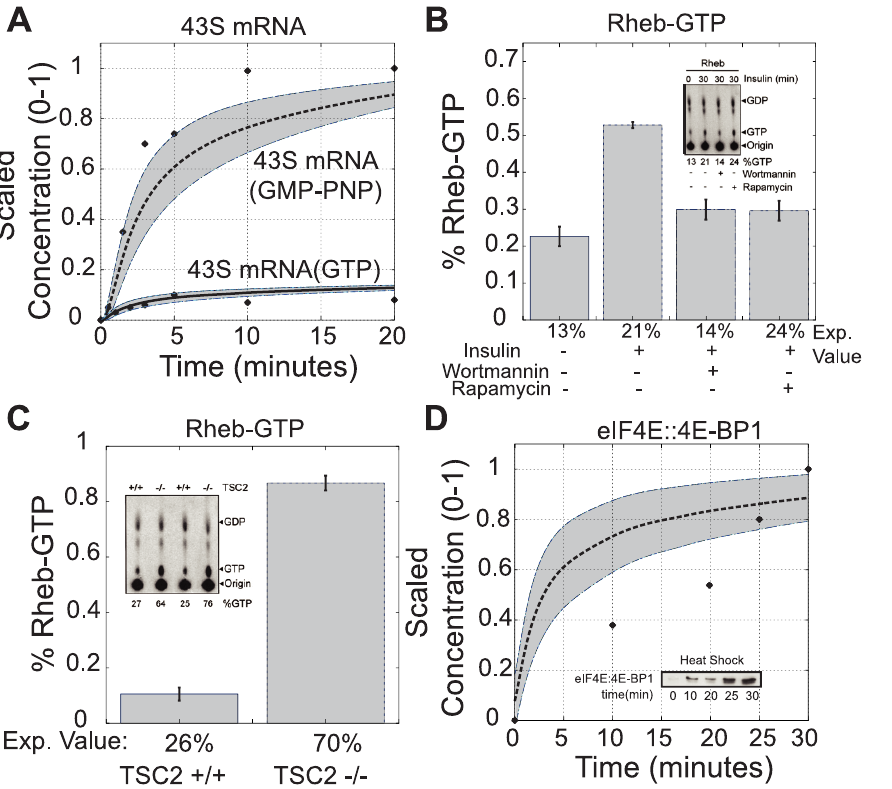
Figure 4. Blind model predictions for the ensemble (N=400). The predictive ability of model ensemble was assessed by comparing model performance with novel experimental data. Dotted lines represent the simulation mean of the ensemble, while the shaded region denotes the 99.9% confidence estimate for the mean. The solid dots represent the scaled experimental data. A. In vitro time course for formation of 43S-mRNA complex. A slowly-hydrolyzable GTP homologue (GMP-PNP) was used in place of GTP to isolate formation of this intermediate complex. GMP-PNP data was used for training while GTP data was used for validation. B. Percent of Rheb-GTP to Rheb-GDP in the presence of insulin, wortmannin and rapamycin (A14 NIH 3T3 cells). C. Percent of Rheb-GTP to Rheb-GDP in wildtype and TSC2 lacking cells (MEF cells). D. 4EBP1 bound EIF4E in the presence of heat shock (CHO.K1 cells).